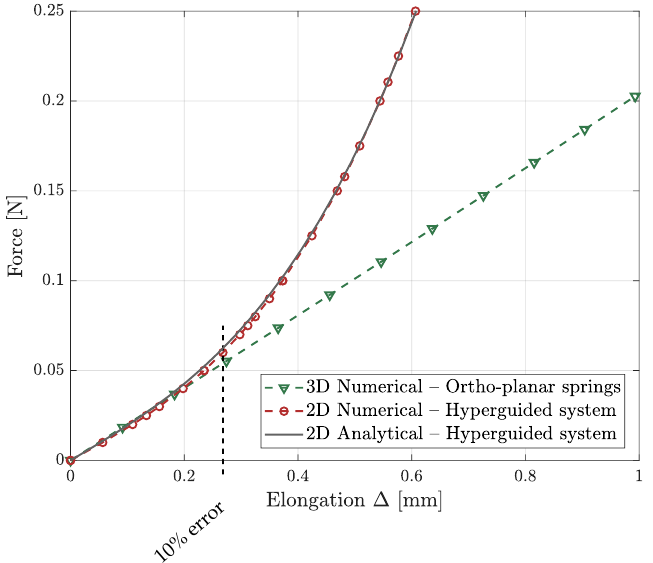
Figure A3. Comparison between the 3D finite element model of one ortho-planar spring and the 2D simplification based on the hyper-guided structure. The 2D simplification was solved numerically in COMSOL Multiphysics and with the analytical